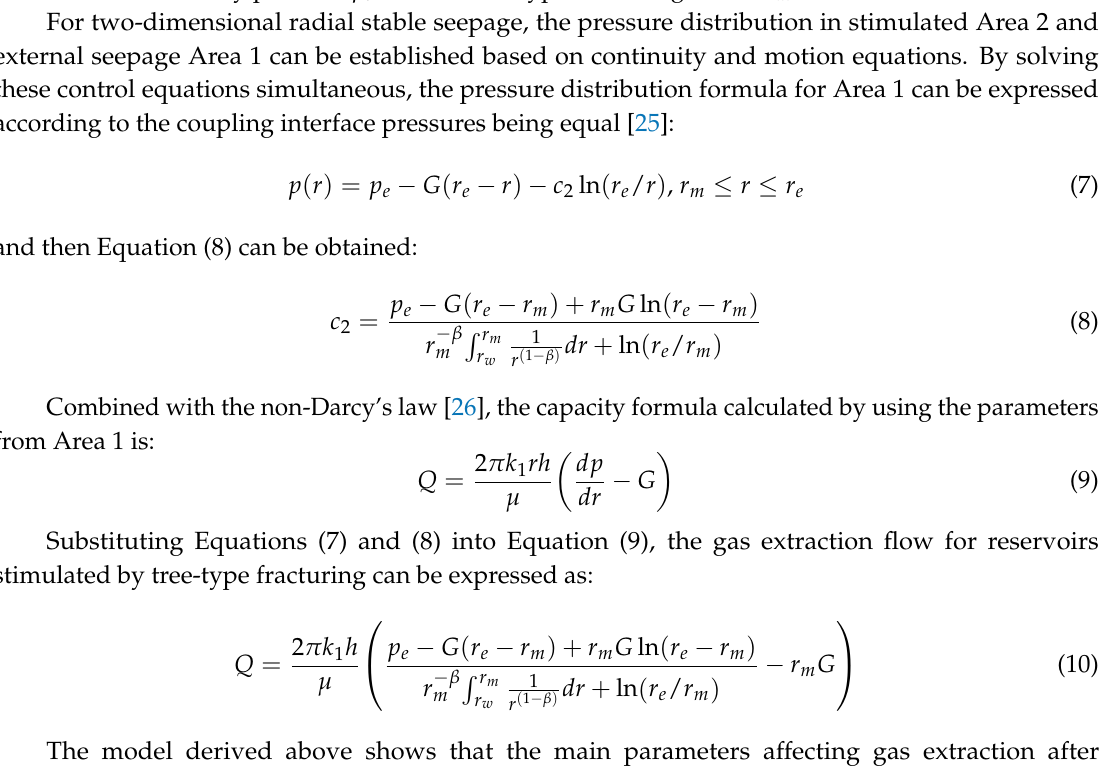
Figure 2b. The yellow area (Area 2) represents the stimulated volume and the white area (Area 1) represents the area not affected by tree-type fracturing but in the seepage area. The thick red lines portray the sub-boreholes and the red circles portray the fracture network composed of hydraulic fractures and micro fractures in the coal. The blue arrows illustrate gas flow directions. Gas first flows to the fractures and then to the main borehole via the fracture network. Because the seepage distances are short, the pressure needed to drive the gas to the fractures is greatly reduced, thus achieving the effect of stimulating the